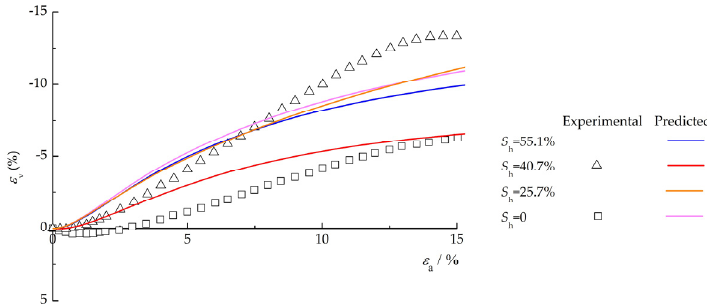
Figure 2. Comparison of the predicted stress–strain curves with the experimental results [22].